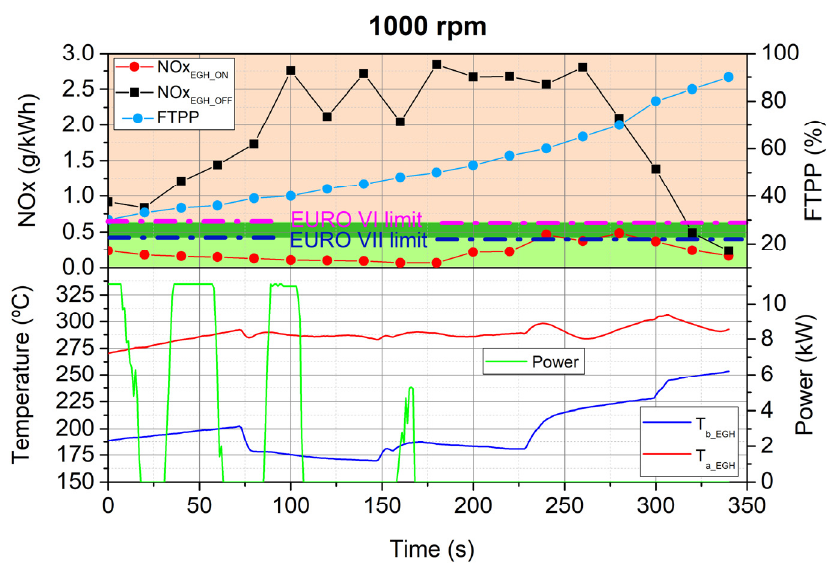
Figure 6. Results from Test 1 including NOx values, FTPP and gas temperatures at 1000 rpm.